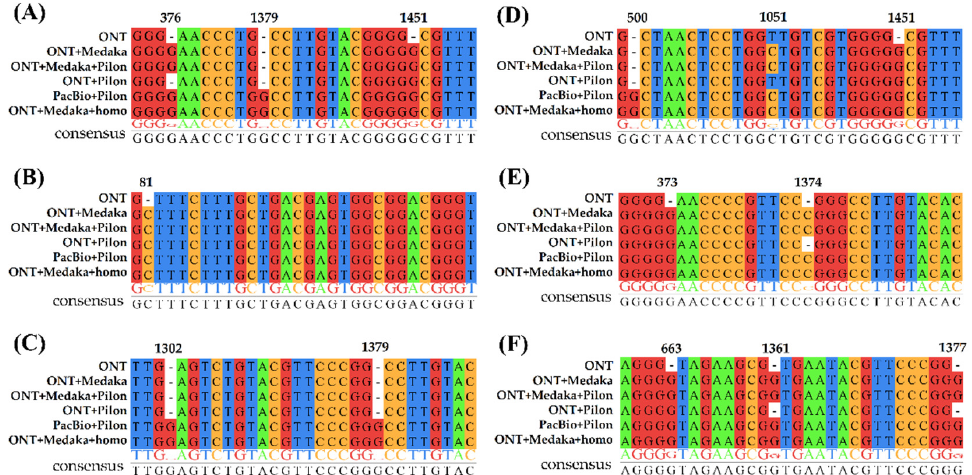
Figure 4. 16S rDNA sequence alignment results of assembled genomes. ( A – F ) Alignment of 16S rDNA copies of each assembly with starting positions at about 366,200, 204,400, 2,015,700, 2,083,100, 776,000, and 1,925,000, respectively. Table 5. Results of BLAT alignment between transcripts and assembled